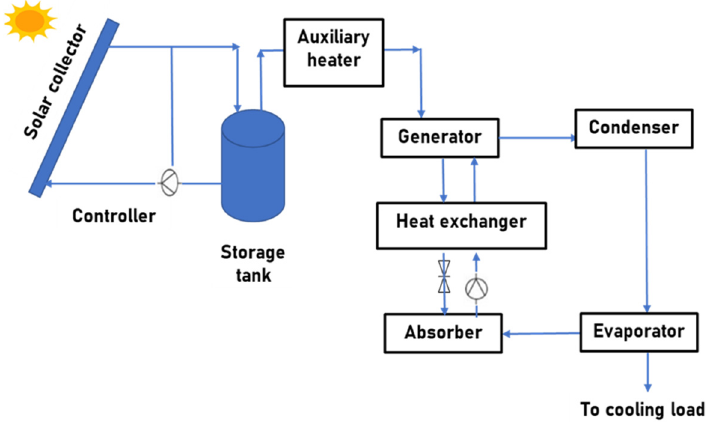
Figure 4. A schematic diagram of a solar-powered absorption refrigeration system.